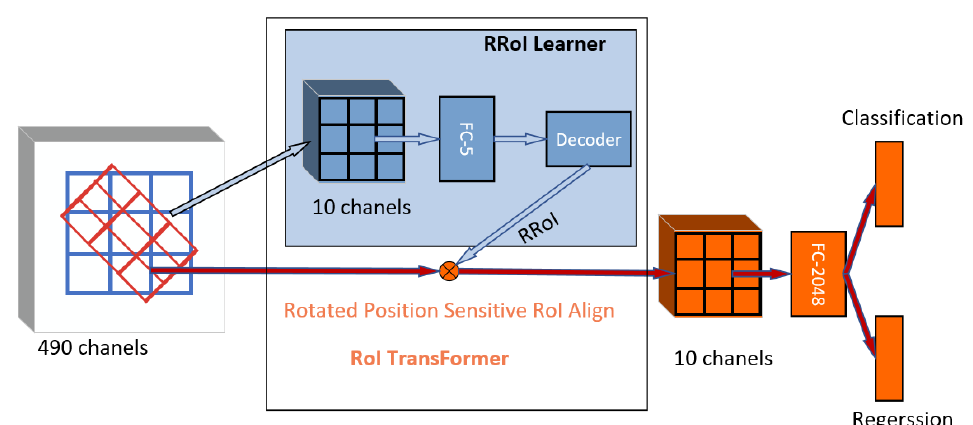
Figure 12. The network architecture of RoI Transformer.